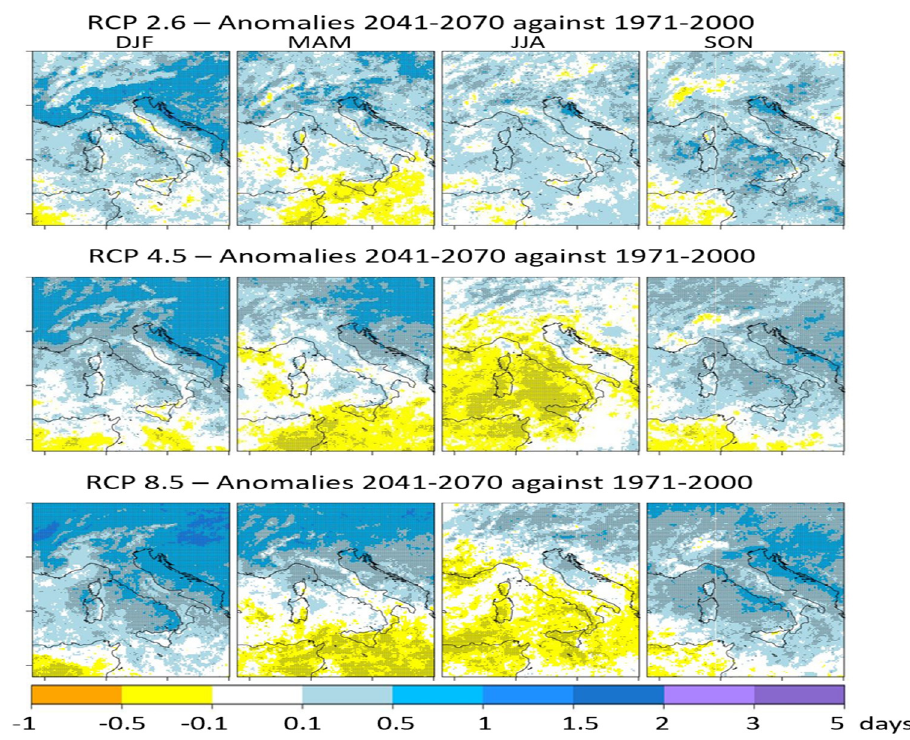
Figure 15. As Figure 14, but for the future scenario 2041–2070.